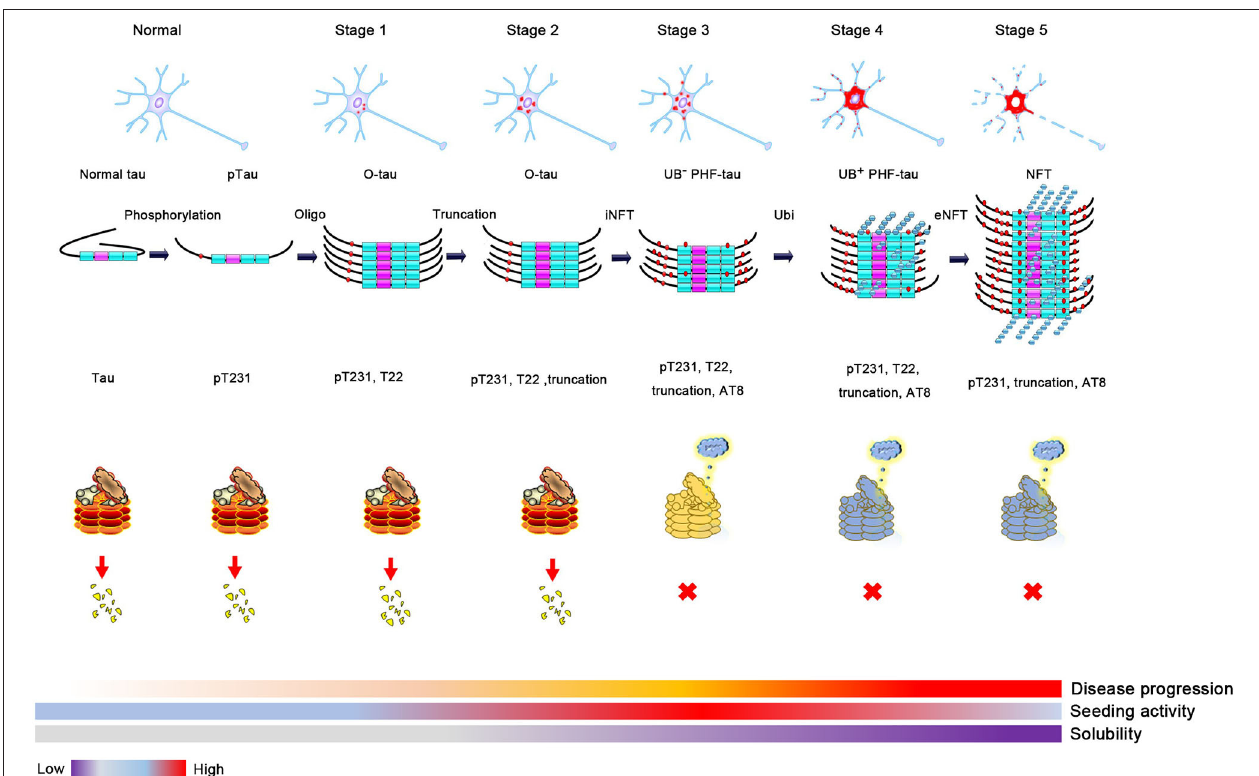
FIGURE 2 | The proposed process of tau aggregation. Phosphorylation changes tau conformation and induces oligomer tau aggregation. Soluble oligomer tau has higher toxicity and seeding activity. Proteases, such as caspase 3, calpain, or legumain, can cleavage tau and result in tau truncation when the cell is toxic. Monomer and oligomer tau can be ubiquitinated and degraded by the proteasome. However, ubiquitin-positive tau aggregation will be accumulated when the activity of proteasome is decreased (high activity, red; medial activity, yellow; and low activity, blue), which will decrease the seeding activity and solubility of tau aggregation and finally lead to the formation of neurofibrillary tangles